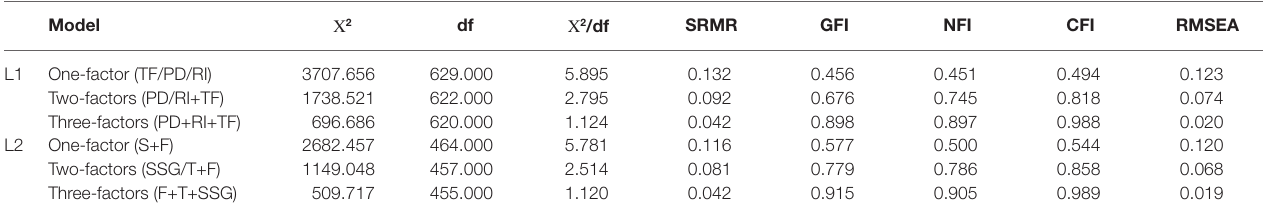
TABLE 3 | Confirmatory factor analysis (CFA)